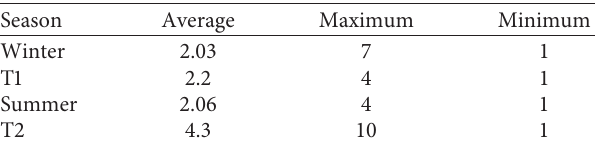
Table 5: Duration of symptoms (in days) at presentation by season for complicated